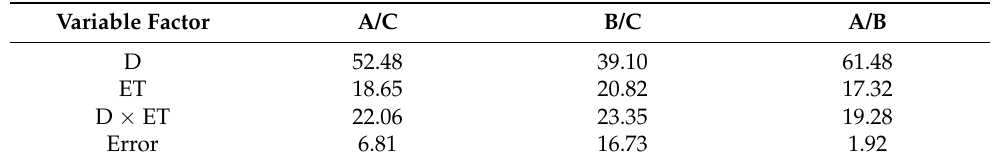
Table 5. Percentage share of factors contributing to the formation of aliphatic and hydrophilic SOM